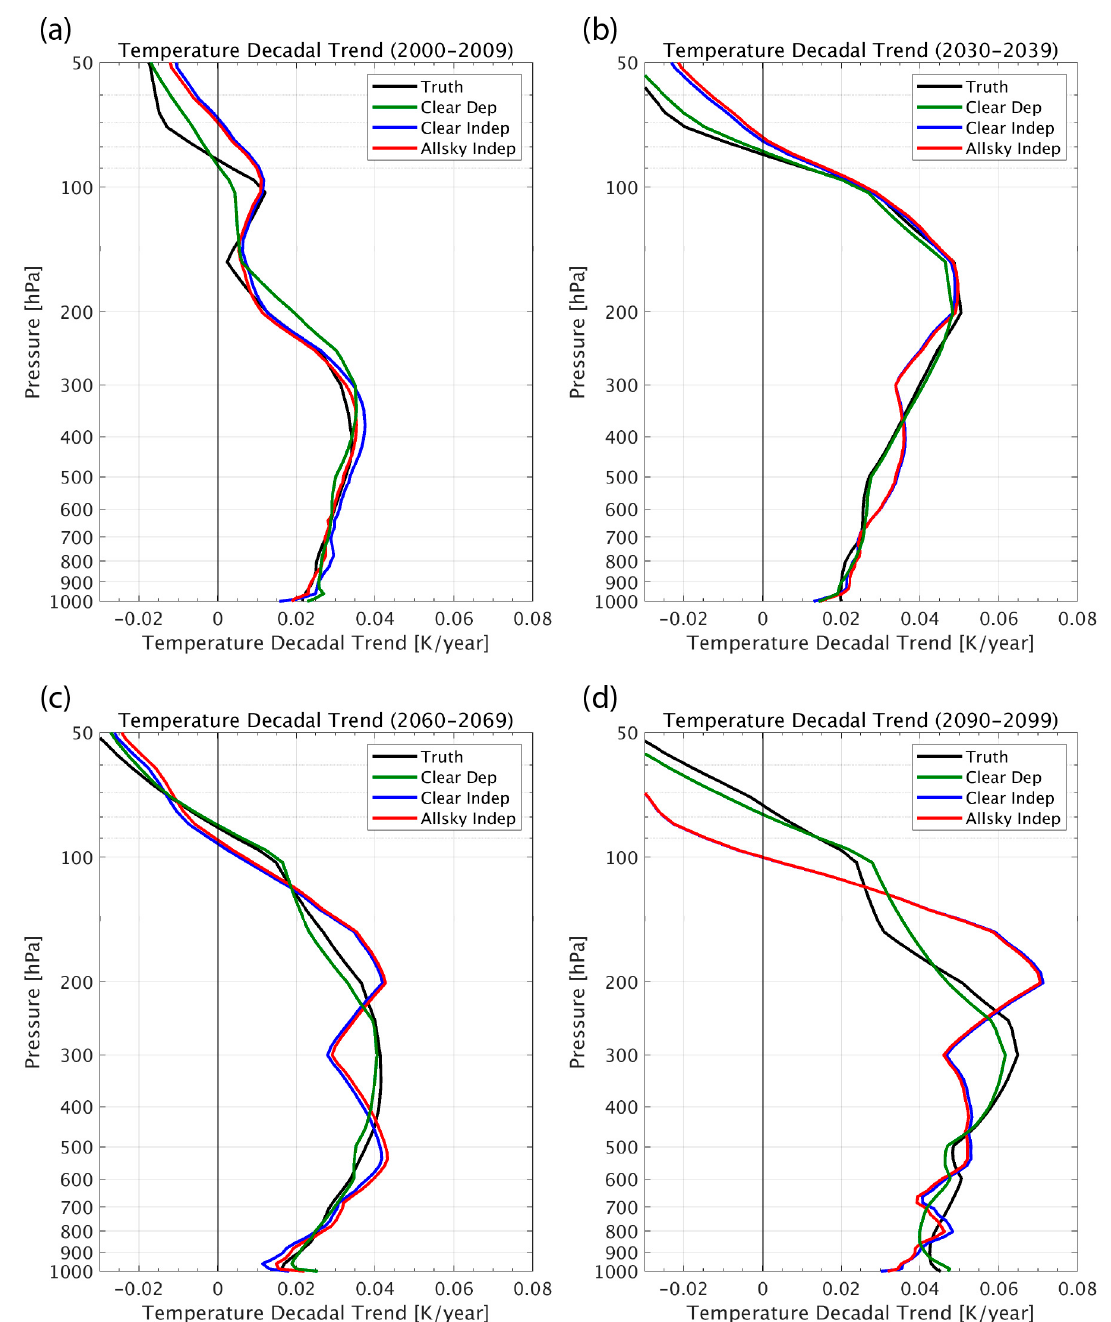
Figure 3. Examples of decadal trend profiles (K / year) produced by a 100-year climate model simulation for four decades: ( a ) 2000 - 2009, ( b ) 2030 - 2039, ( c ) 2060 - 2069, and ( d ) 2090 – 2099. The “Truth” (black curve) decadal trends are compared to decadal trends retrieved from simulated hyperspectral infrared radiance measurements, assuming: clear-sky conditions using a linear regression model trained with the climate model-produced atmospheric conditions (Clear Dep, green curve); clear-sky conditions using a linear regression model trained with contemporary global weather observation atmospheric conditions (Clear Indep, blue curve); and all-sky conditions using a linear regression model trained with contemporary global weather observation atmospheric conditions (All-sky Indep, red curve).